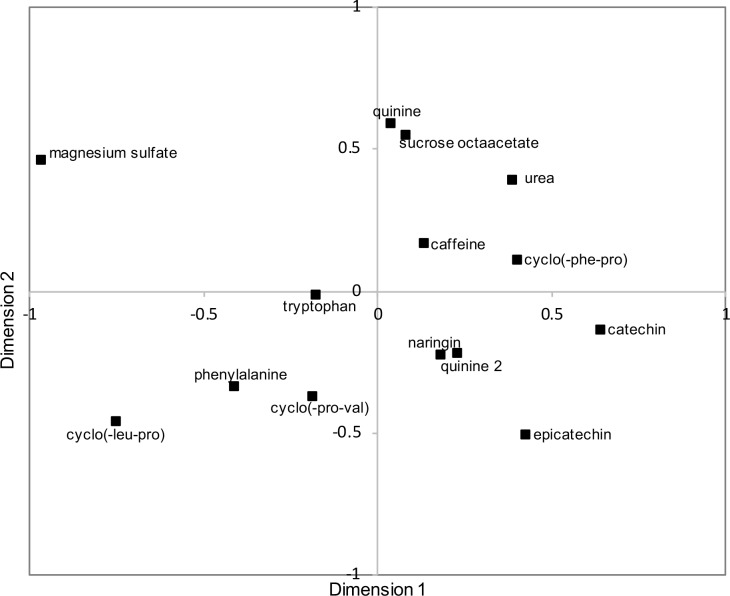
Perceptual map from Multidimensional Scaling (MDS) from similarity matrix obtained from napping experiments (Tucker’s coefficient of congruence = 0.984).